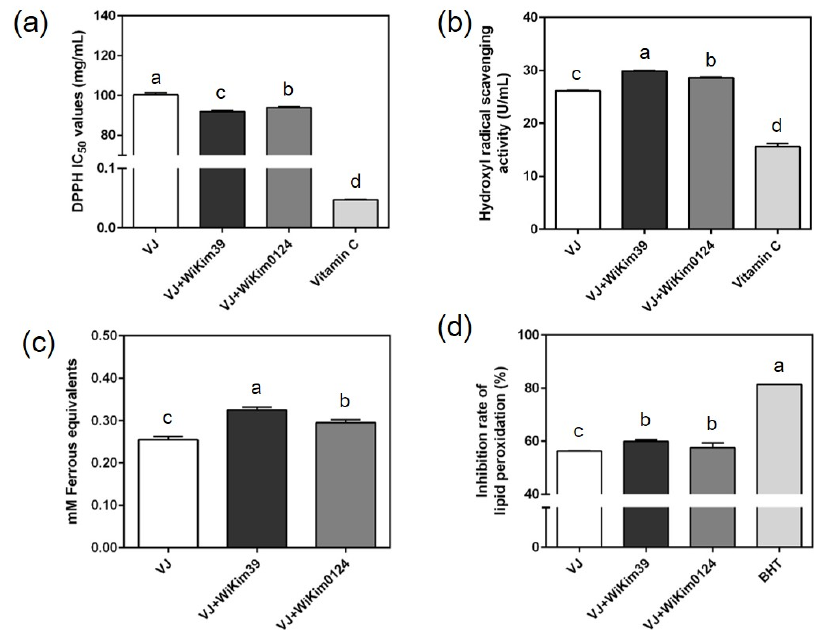
Figure 1. Antioxidant capacities of vegetable juice fermented with lactic acid bacteria. ( a ) DPPH radical scavenging activity, ( b ) hydroxyl radical scavenging activity, ( c ) ferric-reducing antioxidant power assay, ( d ) inhibition rate of lipid peroxidation assay (TBARS). At least triplicate analyses were performed. Different letters above the columns denote significant differences ( p < 0.05). DPPH: 2,2- Diphenyl-1-picrylhydrazyl radical, TBARS: thiobarbituric acid reactive substances.